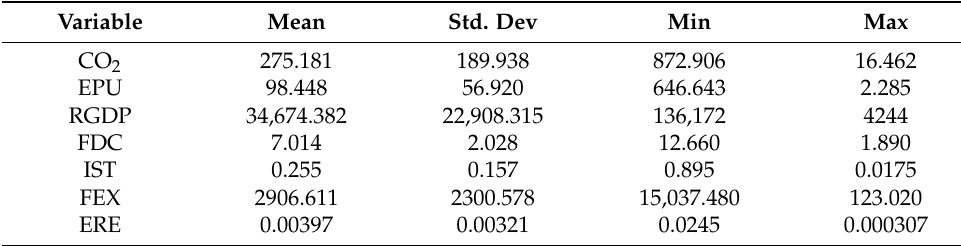
Table 1. Descriptive statistics of model